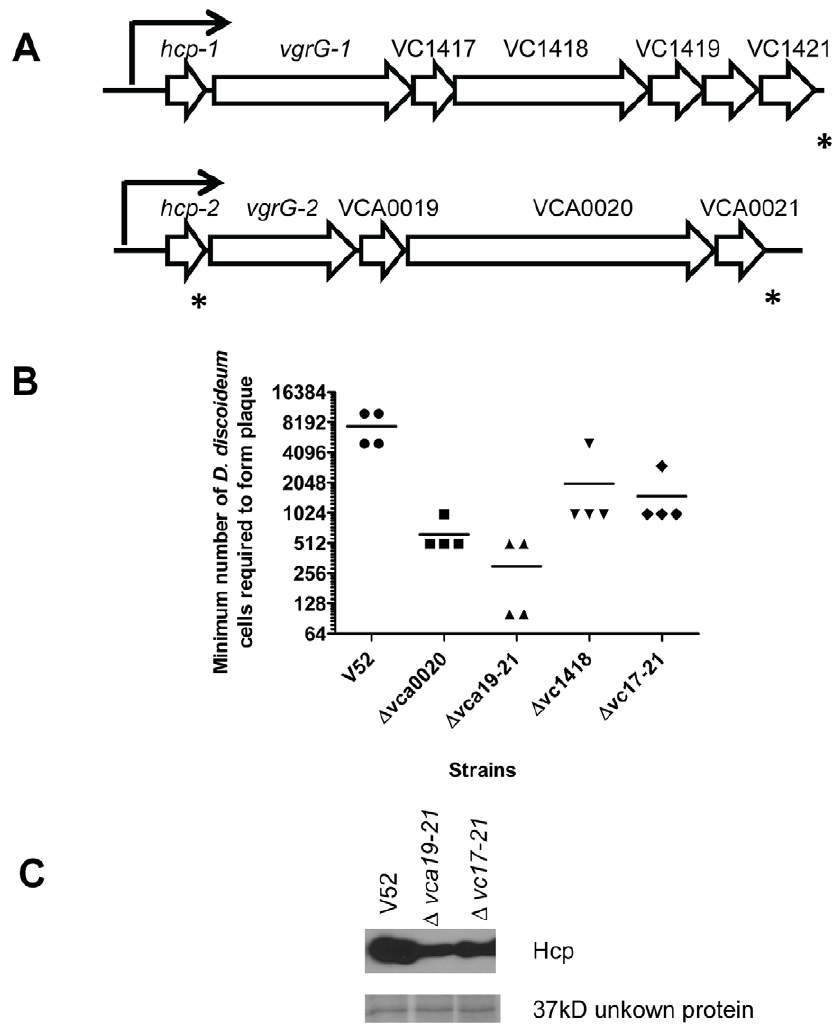
Figure 4. Genes encoded in the vgrG-1 and vgrG-2 operons contribute to V.cholerae virulence and Hcp secretion. (A) Schematic representation of genes organization in the putative vgrG-1 and vgrG-2 operons. The prompters predicted by PromScan and the terminitors predicted by TransTerm were indicated by arrows and stars respectively. (B) The minimum number of Dictyostelieum amoebae cells required to form plaque on the lawns of different mutants in vgrG-1 and vgrG-2 operons. (C) Deletion of genes in vgrG-1 and vgrG-2 operons affected Hcp secretion examined by western blot. A 37 kD unknown protein demonstrated by Ponceau S staining was used as a control to show the equal protein loading.